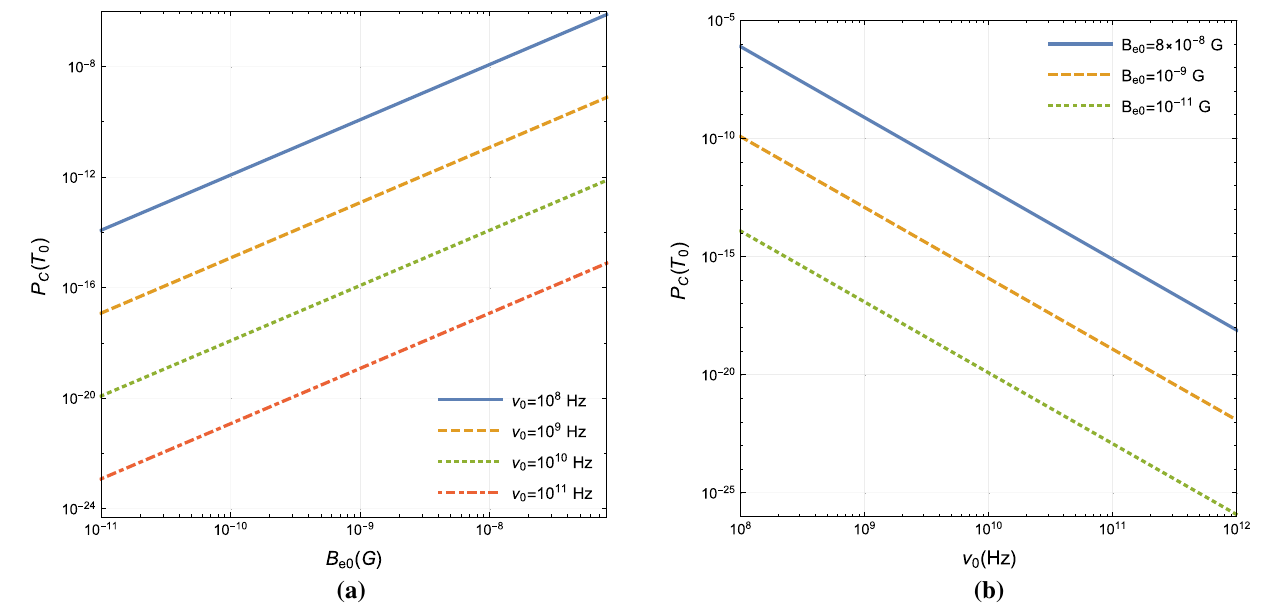
Fig. 4 In a logarithmicscaleplotsofthedegreeofcircularpolarization P C ( T 0 ) as a function of the magnetic field amplitude B e 0 for values of the CMB frequencies ν 0 = 10 8 Hz, ν 0 = 10 9 Hz, ν 0 = 10 10 Hz and ν = 10 11 Hz are shown. In b logarithmic scale plots of the degree of 0